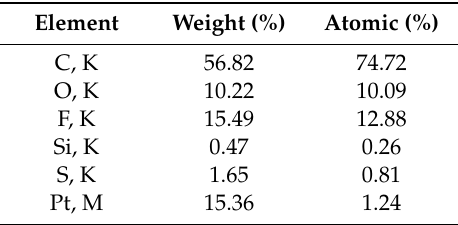
Table 6. Energy Dispersive Spectroscopy (EDS) result for membrane electrode assembly (MEA) cathode (hydrogen)